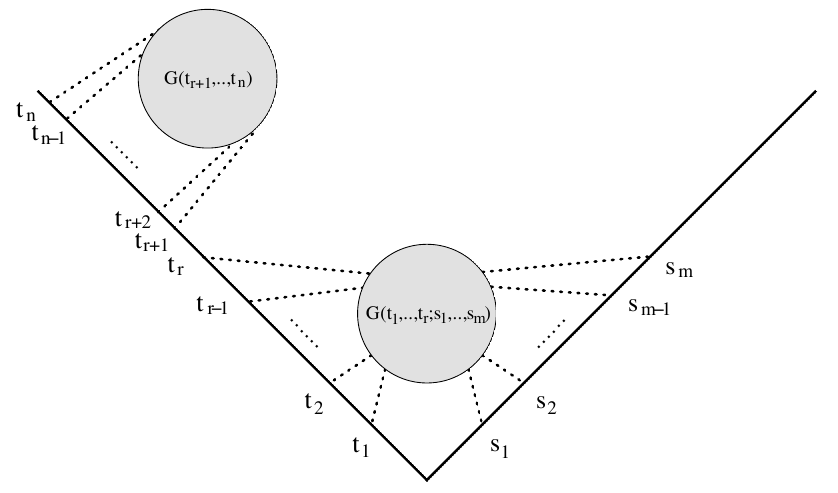
Figure 5 . Factorization of quantum corrections to the cusped